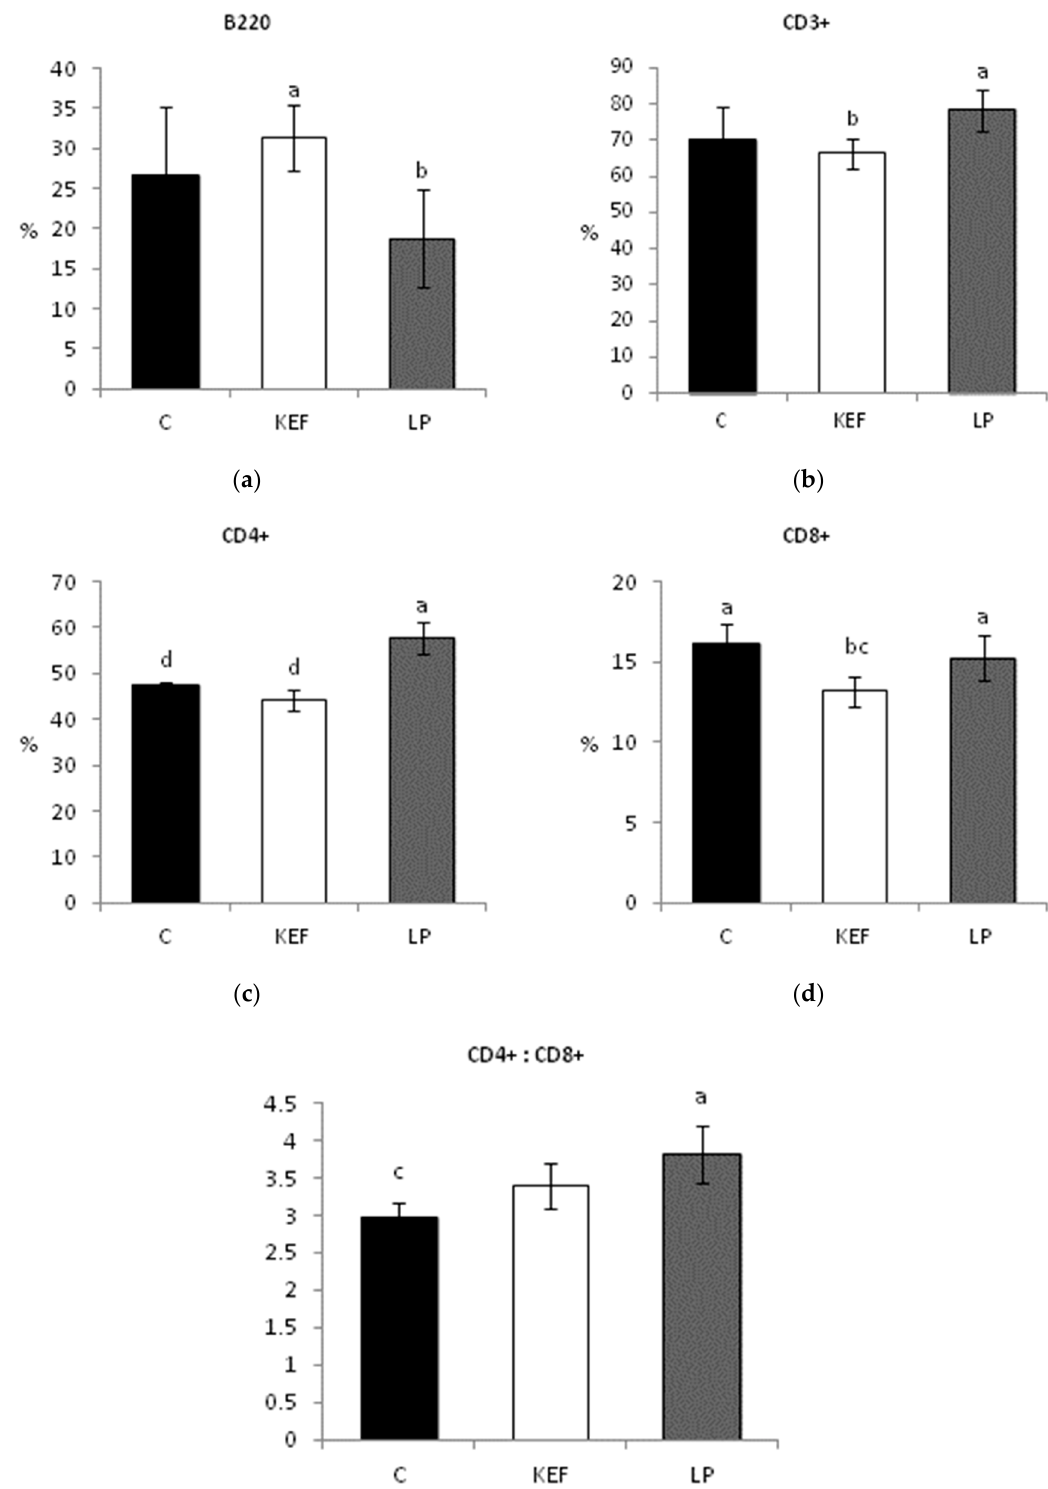
Figure 5. Effect of application of L. paracasei Ž2 and kefir on percentages of: ( a ) B220, ( b ) CD3 + , ( c ) CD4 + and ( d ) CD8 + and ( e ) ratio of CD4 + :CD8 + lymphocytes isolated from peripheral blood in mice ( n = 6). ab p < 0.05; ac p < 0.01; ad p < 0.001.